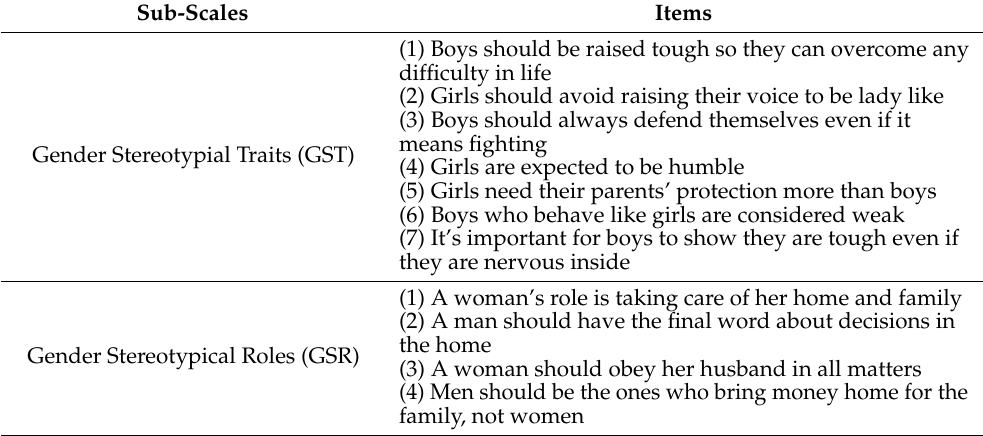
Gender Stereotypical Roles